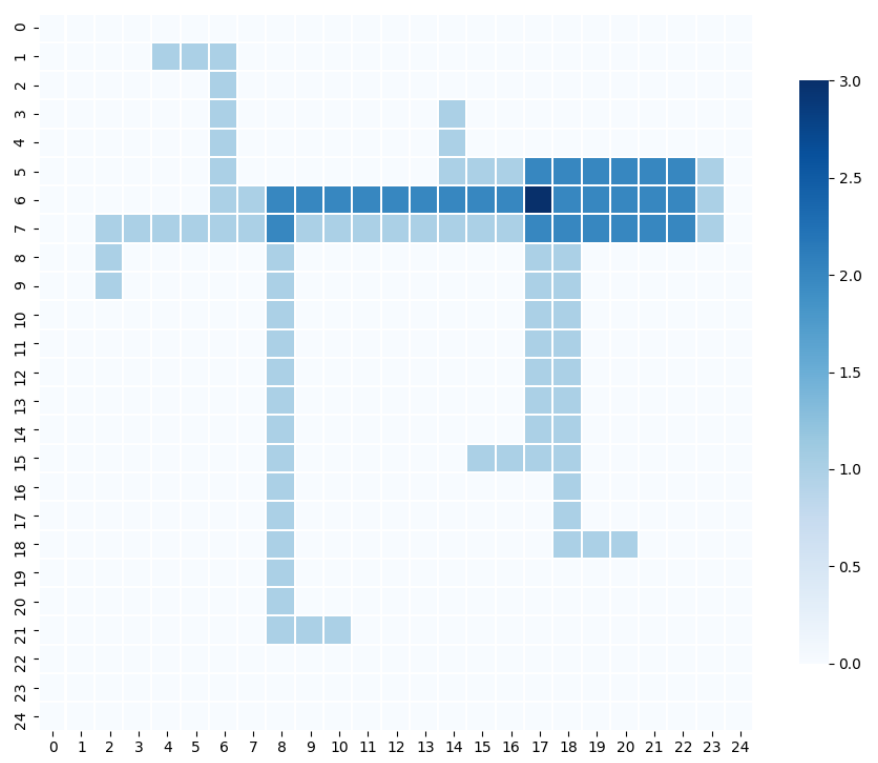
Figure 4. An example heatmap of the robot paths within the warehouse. Darker shades of blue indicate more traffic.